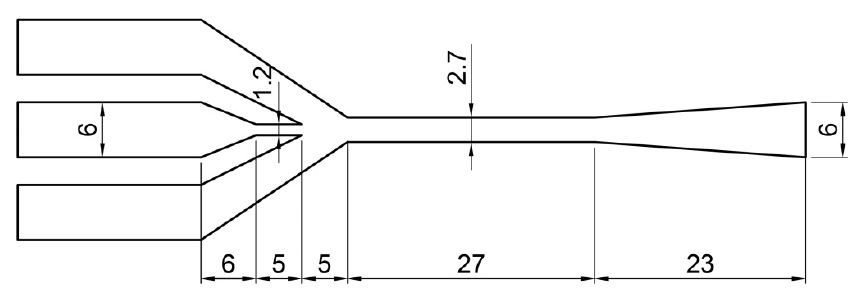
Figure 5. Structural sizes of ejector from the published literature [40]. Table 3. Measurement uncertainties of instrument from the published literature [40].